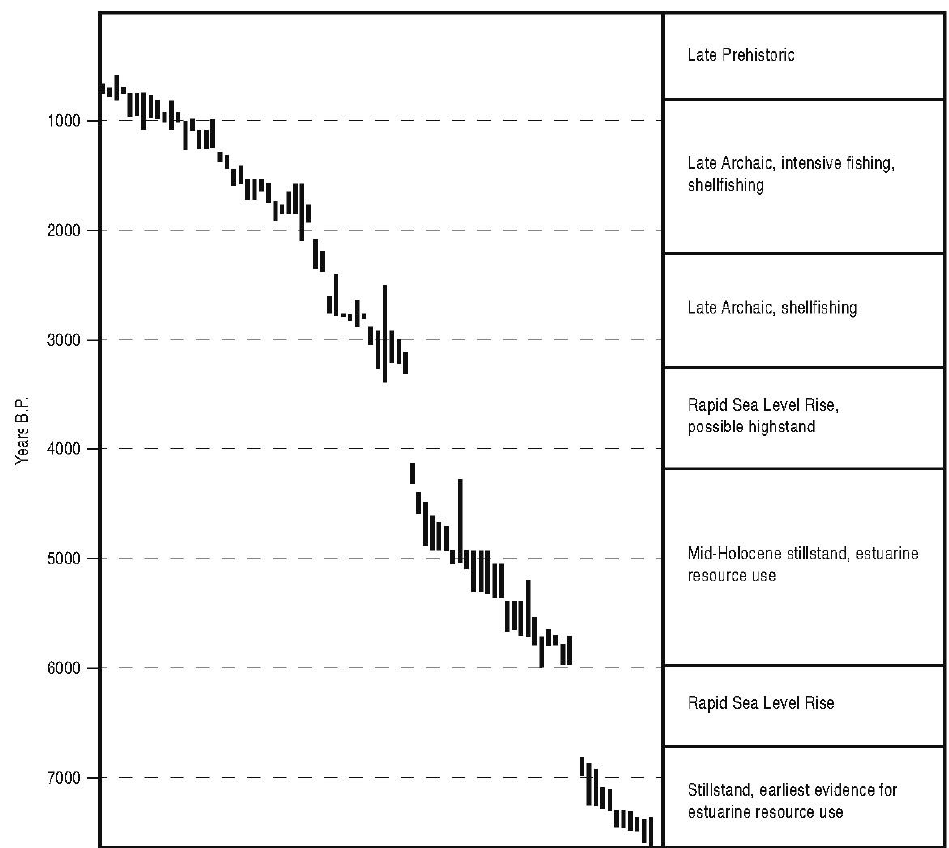
Figure 9. Radiocarbon date distribution of Central Texas Coast shell midden sites (source: [18]). Among clam species found at regional shell middens, Rangia flexuosa is limited to pre-4500 BP contexts, while R. cuneata appears first after 3000 BP (modified from [2,12]). Breaks in human occupation of the TGCP are inferred according to both a hiatus in dated remains as well as the absence of coeval diagnostic lithic artefacts for the periods 6700 to 6000 BP and 4000 to 3000 BP.